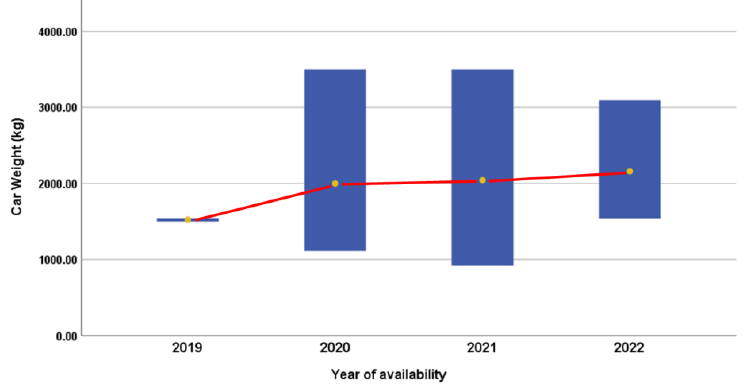
Figure 9. Range bar variation (min, max, mean) representation of vehicle weight vs. year of availa- bility in market.